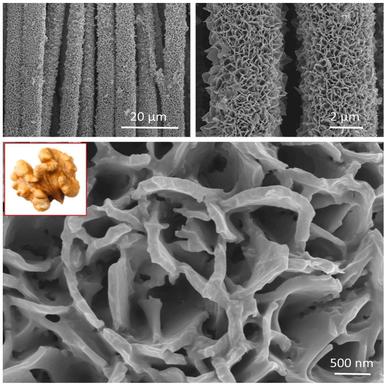
Representative low-magnification FESEM images (a-b) and (c) high-magnification FESEM image of Co-O-NSs@CFC.